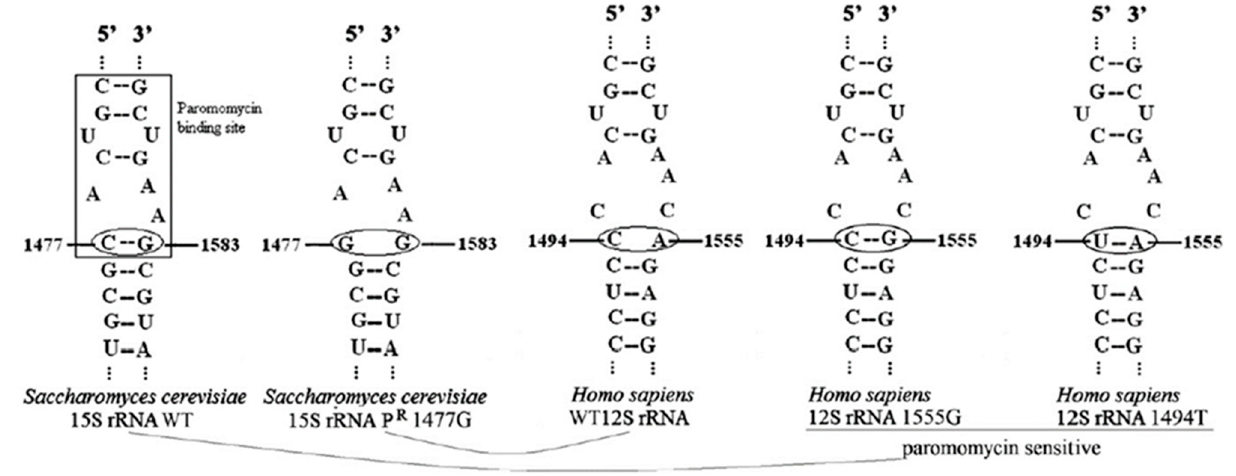
Figure 1. Secondary structure of the A-site of the wild type and P R yeast strain 15S mt-rRNA, and of the wild type and aminoglycoside-sensitive human 12S mt-rRNA, as reported in [69]. Different mutations have been studied in P R strains. First, point mutations and dele- tion in MSS1 were shown to determine a respiratory impairment, caused by the block in the splicing of introns of COX1 mRNA due to the inhibition of the synthesis of maturases encoded by mtDNA genes, only in a P R background [27]. Second, deletions in MTO1 or MSS1 showed a significant growth defect just in P R strains [24], probably due to the im- pairment of interaction between the A-site of the ribosome, where the 15S mt-RNA muta- tion localizes, and the unmodified tRNAs which are the substrate of the Mto1/Mss1 com- plex [136]. Third, the deletion of MTO2 , when studied in a P R background, showed an OXPHOS defect due to a defective expression of some mitochondrial genes, among which COB and COX1 [29]. Last, mutations in the TRM5 gene were studied both in paromomy- cin-sensitive and paromomycin-resistant backgrounds; in the latter case, a worsening of the phenotype was visible [88], as described in Section 2.3.